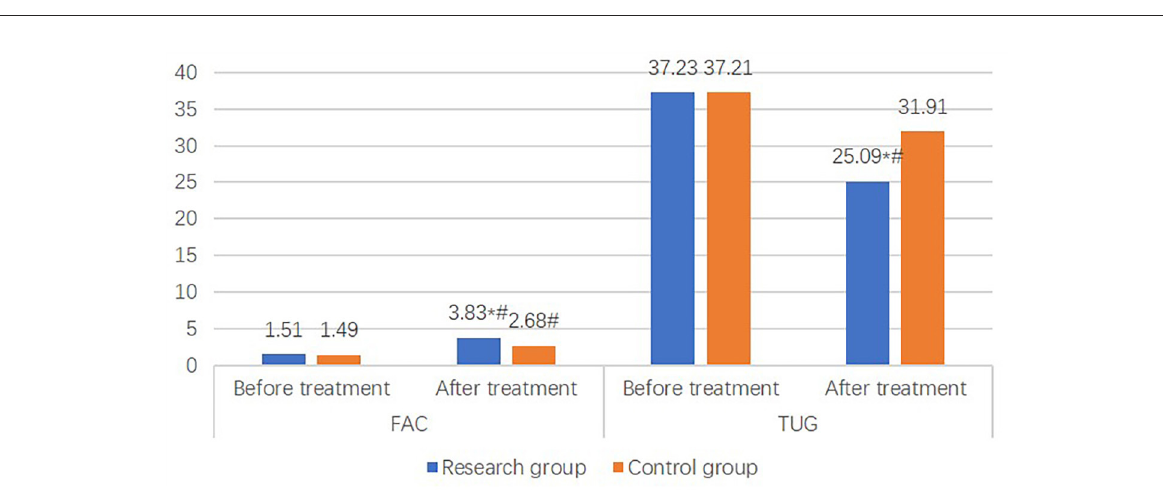
FIGURE5 Comparison of walking ability between the two groups. Walking ability in the research group including functional walking scale, timed Up & Go improved after treatment. Additionally, walking ability of the research group after treatment was significantly better than that of the control